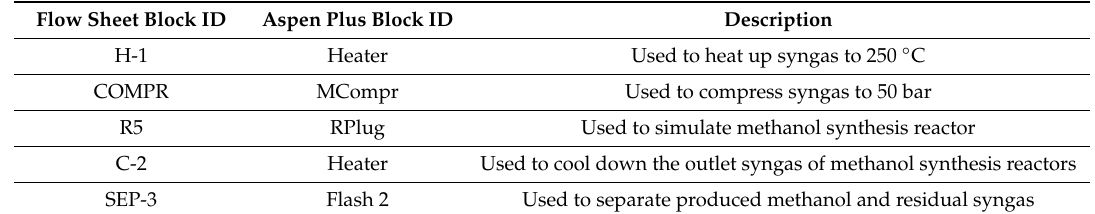
Table 4. Description of Aspen plus block used in methanol synthesis and operating